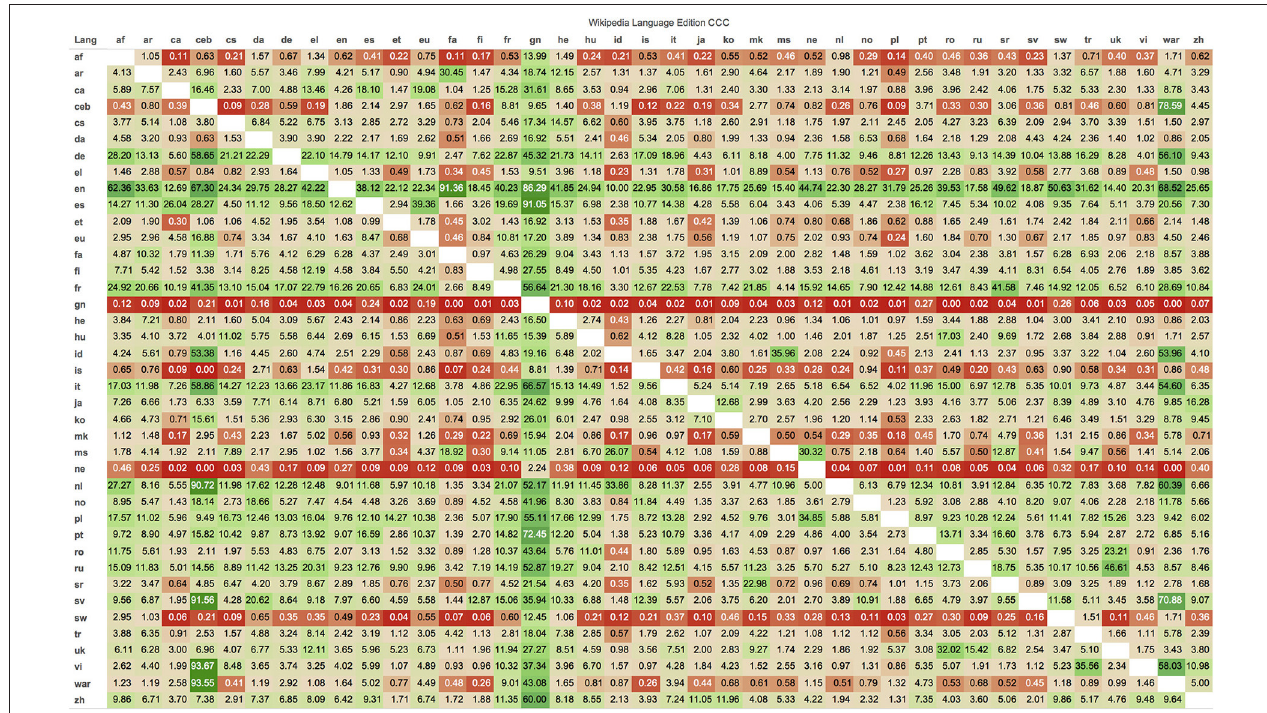
FIGURE 6 | Culture gap: 40 Wikipedia language editions coverage (% articles) of 40 Wikipedia language editions CCC. Each row shows the coverage of other language editions’ CCC. The coverage is calculated as the percentage of a Wikipedia language edition CCC (column) which exists in another Wikipedia language edition (row). For an easy identification of values, cells are colored in a scale of colors from red (to indicate a percentage lower than 1%), to green in a continuum until 93.67% (the highest